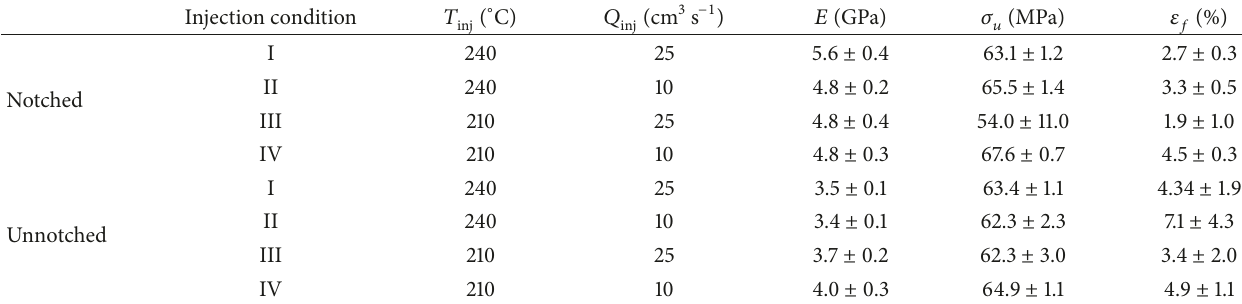
Table 2: Mechanical properties of notched and unnotched PLGA specimens injected with different molding conditions. Injection